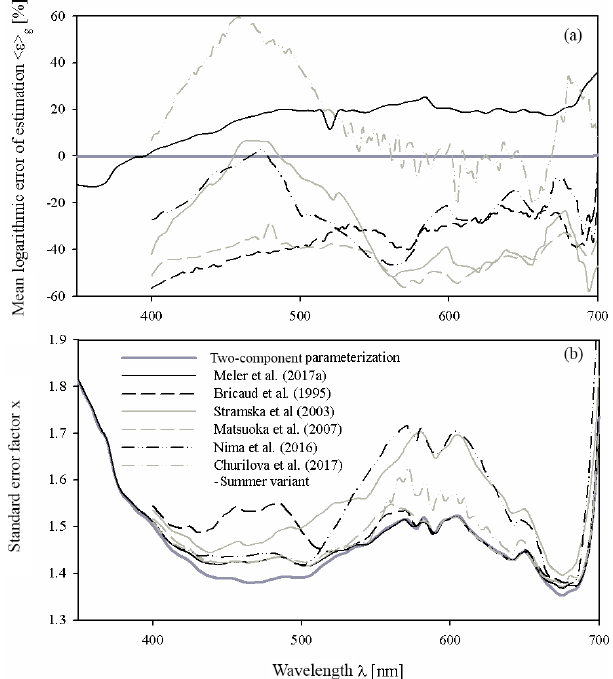
Figure 9. Comparison of the main characteristics of the estimation error logarithmic statistics calculated for various parameterizations of phytoplankton absorption coefficients: (a) the mean logarithmic errors of estimation (cid:104) ε (cid:105) g and (b) the standard error factor x . Dif- ferent curves in these panels represent the two-component parame- terization from this study, the preliminary parameterization accord- ing to Meler et al. (2017a) and selected examples of parameteriza- tions gleaned from the literature (according to Bricaud et al., 1995; Churilova et al., 2017; Nima et al., 2016; Matsuoka et al., 2007; Stramska, 2003) (the legend is given in panel b ). All these parame- terizations were applied to our entire